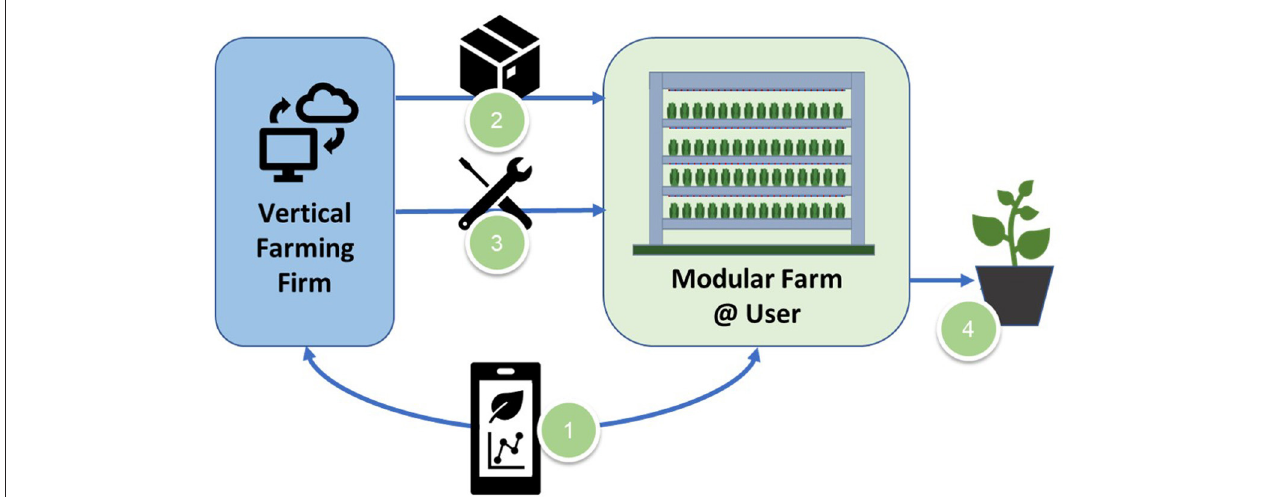
FIGURE 3 | Generalized system and value delivery model for GSS systems. The farm and vertical farming firm are connected through (1) cloud-based application to monitor and provide feedback for (2) consumables and other inputs, (3) possible maintenance and optimization, and finally (4) information about the cultivation and final harvesting